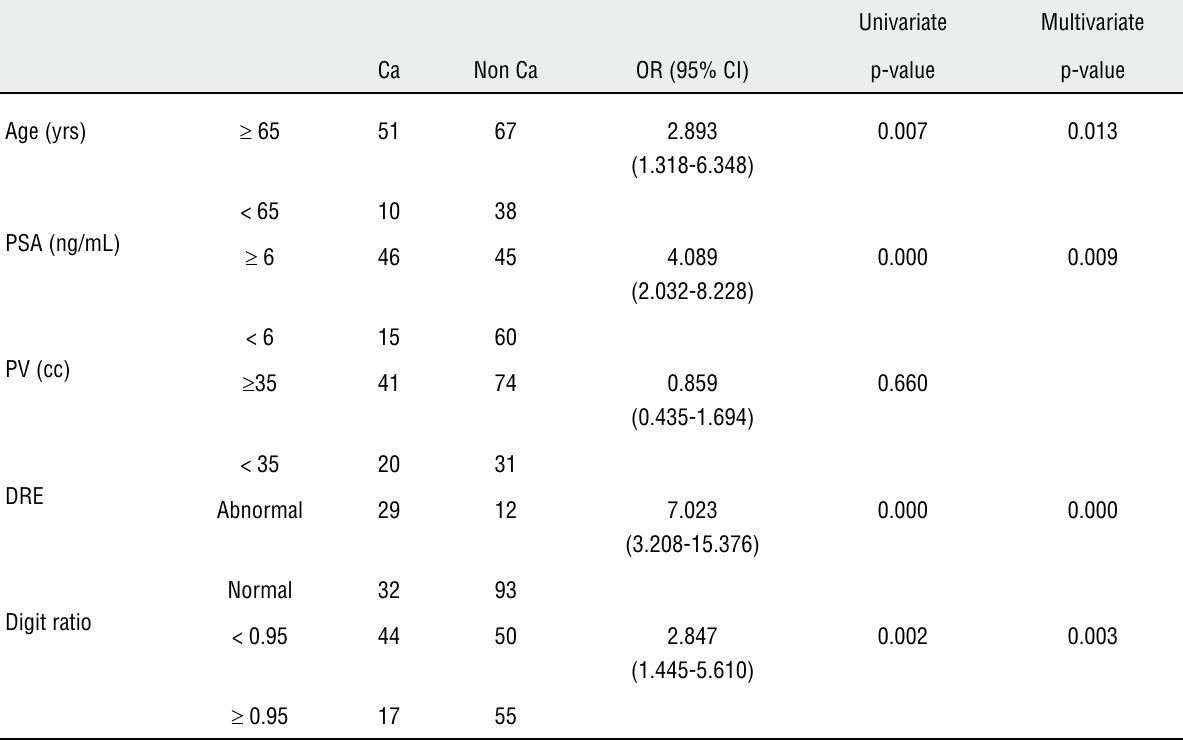
Table 2 - Univariate and multivariate analysis using logistic regression model in biopsied patients (N = 166). Univariate Multivariate Ca Non Ca OR (95% CI) p-value